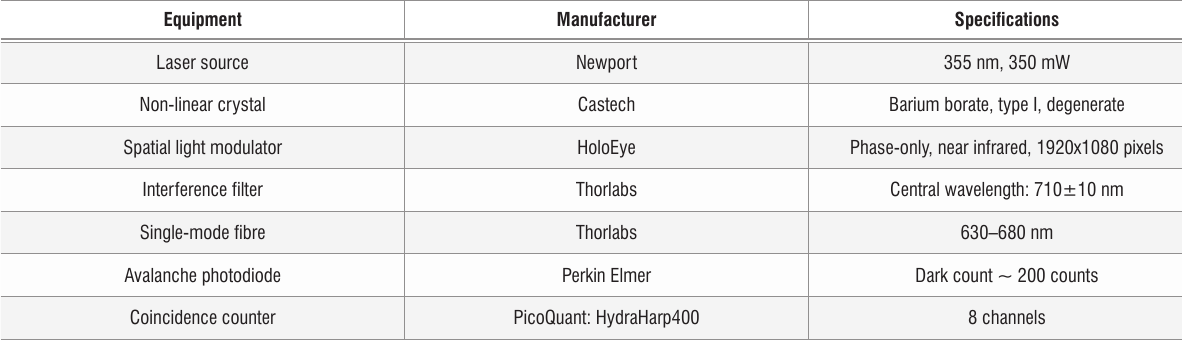
Specifications of the experimental equipment used to perform quantum